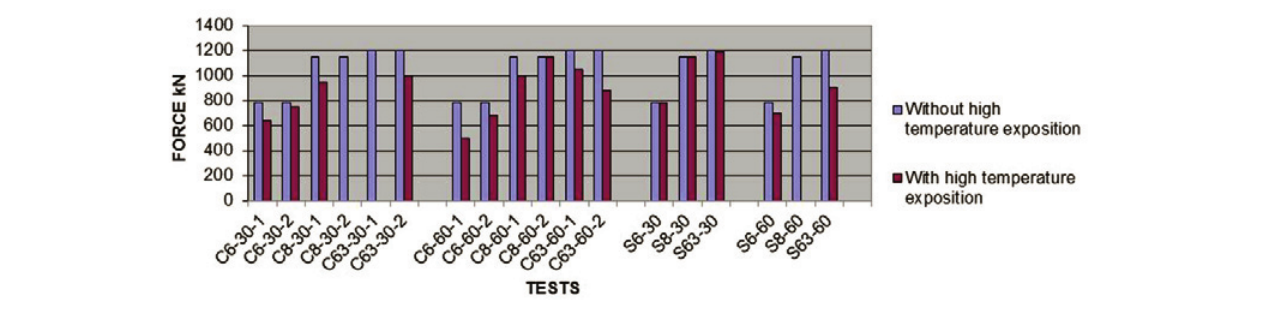
Figure 5 – Yield Strength: columns at room temperature X columns after exposure to high